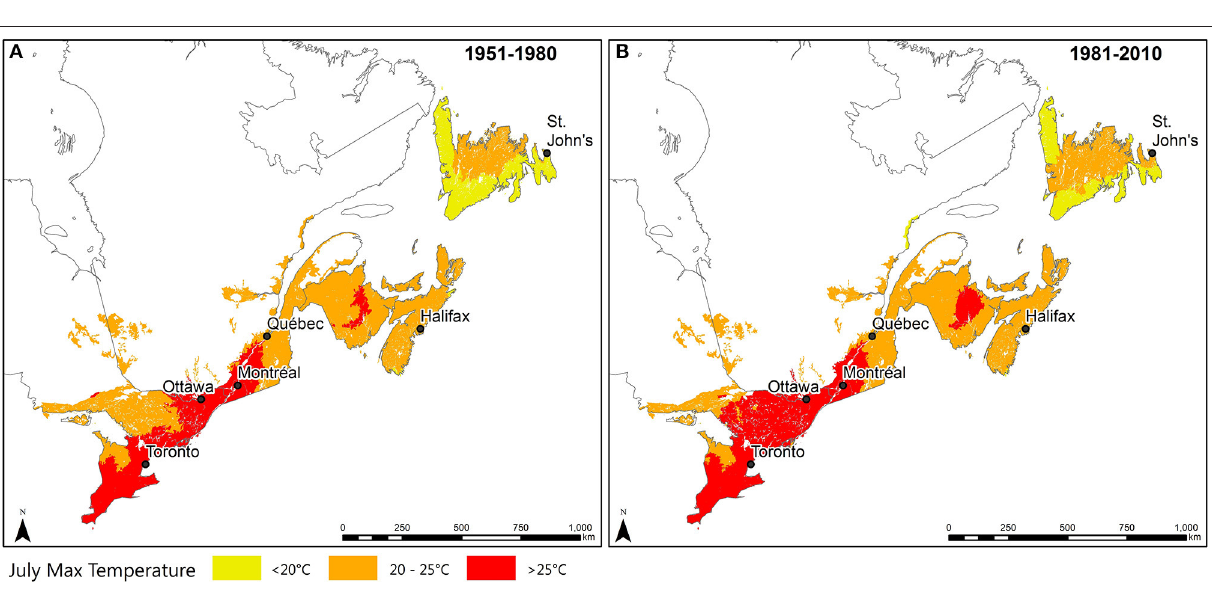
FIGURE 4 | Change in the July maximum temperature in eastern Canada between climate normal periods 1951–1980 (A) and 1981–2010 (B) . Expansion of warmer summer temperatures is visible in southern Ontario and Quebec, central New Brunswick and Newfoundland. Climate data were transposed from a national 10 km grid to 1:1,000,000 soil polygons to facilitate subsequent LSRS